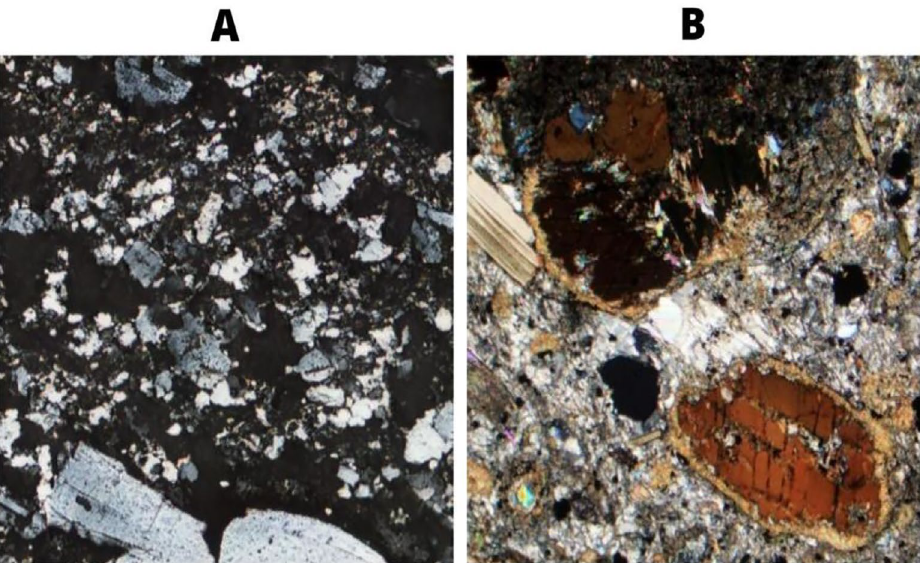
Figure 4. First question presented on the survey. Two images side by side with three answers options, the right image ( B ) being the real one in this case.